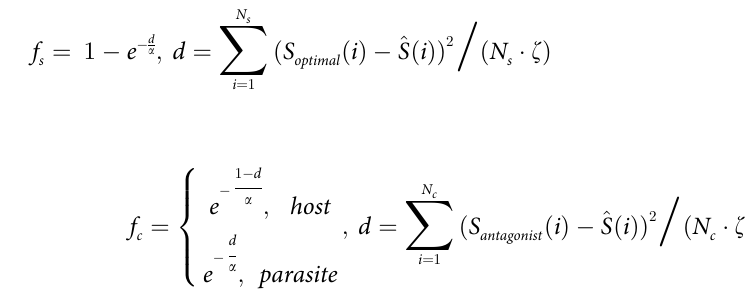
S1 Fig. Fitness function for host (red) and parasite (blue) for different selection pressure